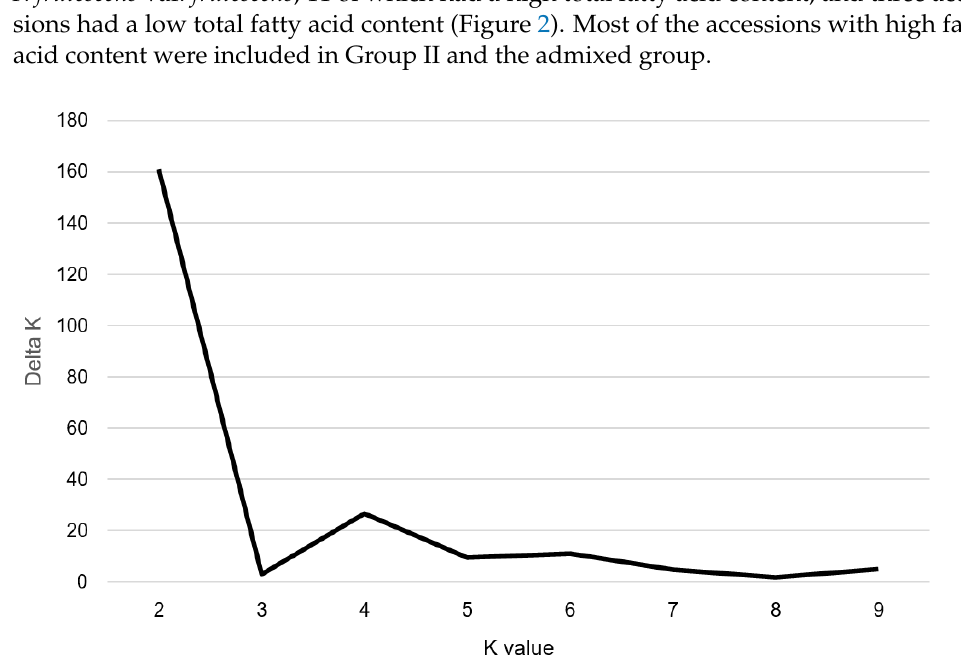
Figure 1. The magnitude of ∆ K as a function of K ; the peak value of ∆ K was at K = 2, suggesting two genetic clusters in the 100 Perilla accessions.